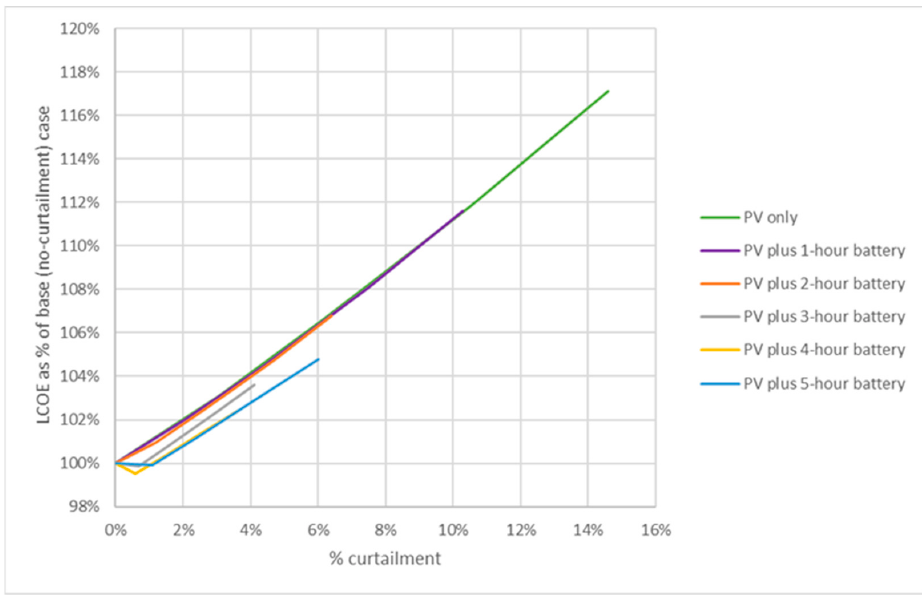
Figure 12. Relationship between percentage increase in LCOE versus percentage increase in curtail- ment for fixed-tilt systems.